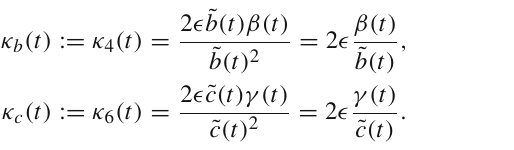
Fig. 2 The t dependence of the expectation value of the operator ˆ ξ 2 defined by (42), (47) for K 1 = K 2 = 0 . 01, K 3 = 0, φ 1 = φ 2 = 0, any t 0 < 0, n 1 = 3. The axis of t is in logarithmic scale. The left panel corresponds to the unperturbed solution ((cid:3) = 0 ), and the right panel